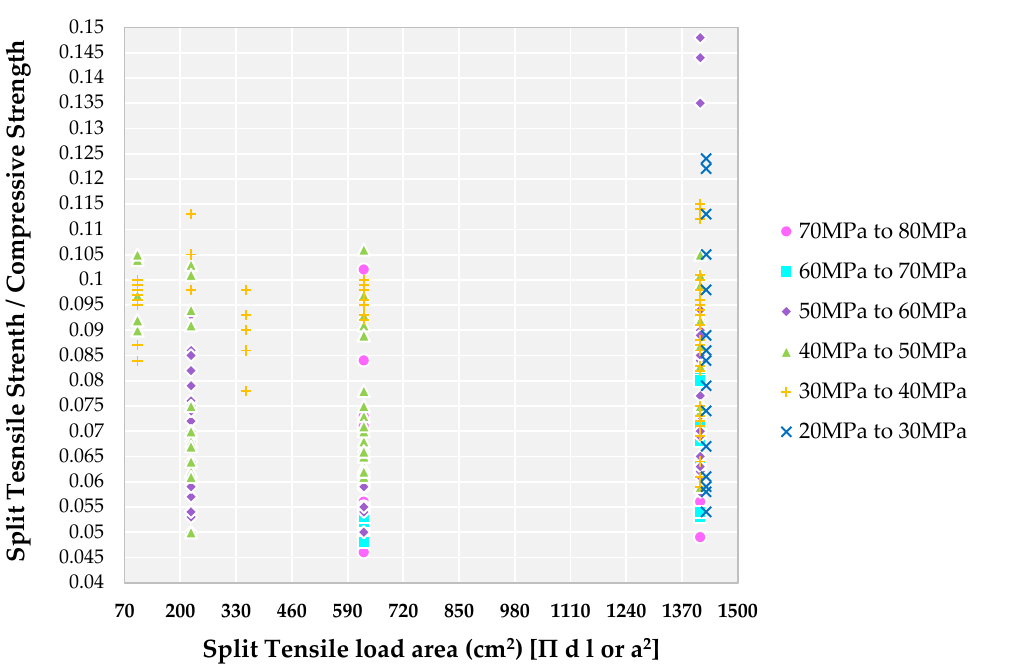
Figure 14. Effect of split tensile load area on various compressive strength of SCC concrete with recycled aggregate according to literature.